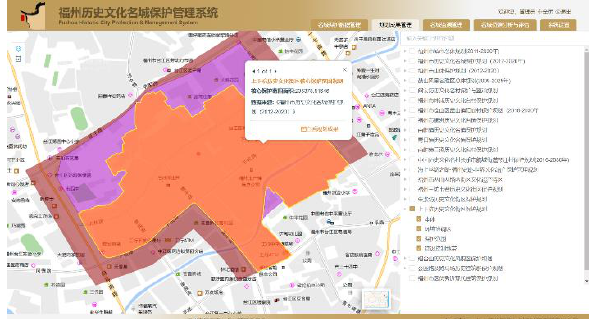
Figure 8. The conservation zoning of Shangxiahang